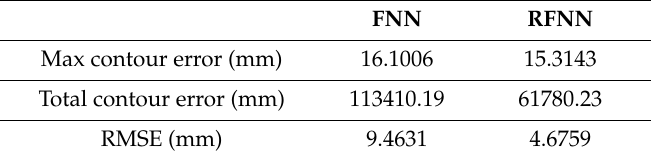
tool feed drive system, and this method did not have restrictions on the trajectories. By the concept of cross-coupling control (CCC), the considered system is transferred into a nonlinear time-varying system due to the time-dependent coordinate transformation; tangential, normal, and bi-normal components of desired contour. Herein, we propose a model-free adaptive coupling controller design approach for multi-axis linear motor system with uncertainty and nonlinear phenomena. The adaptive model-free controller design was established based on an error system by time-varying coordination transformation in order to minimize the contour errors. Specifically, an adaptive controller was Table 2. Comparison performance of FNN and RFNN. developed to control for highly nonlinear system. Through the simulation results, we know that the proposed controller is e ff ective in reducing contour error. The stability of closed-loop system is guaranteed by the Lyapunov method and the adaptation of RFNN is also obtained. Simulation results are introduced to illustrate the e ff